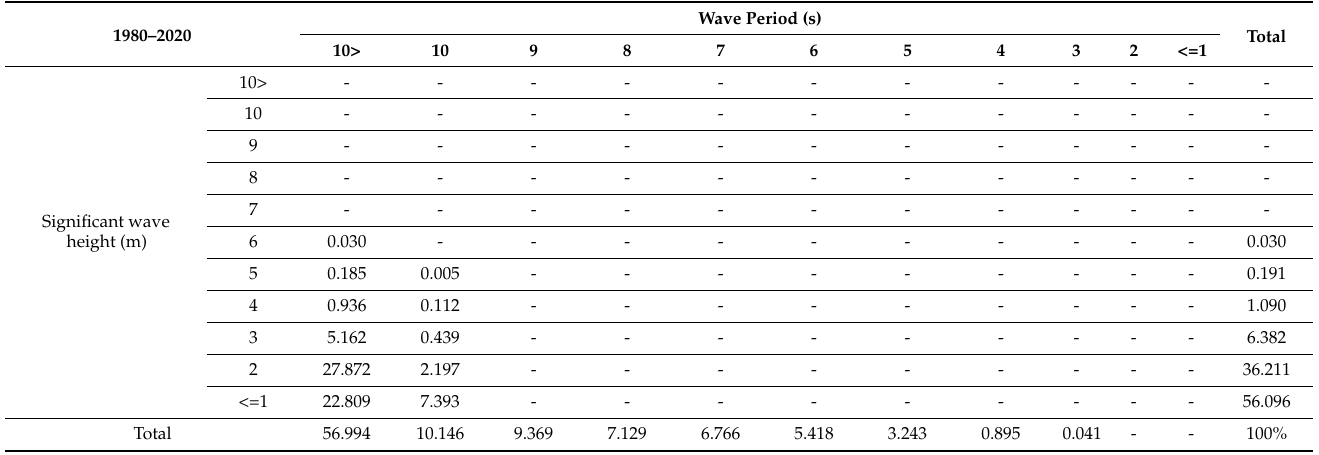
Table 1. Wave characteristics off the study site from 1980 to 2020 (Port Authorities of Spain http: //www.puertos.es accessed on 1 October